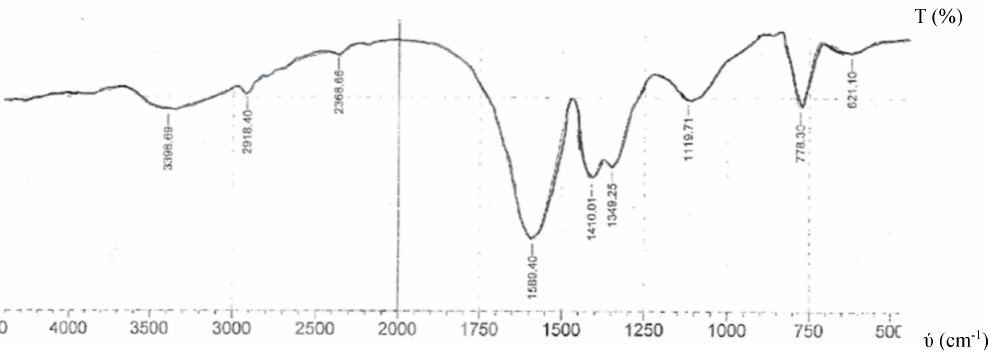
Figure 3. IR spectrum of [Nd(NBTCS) 2 (H 2 O) 2 ]NO 3 .